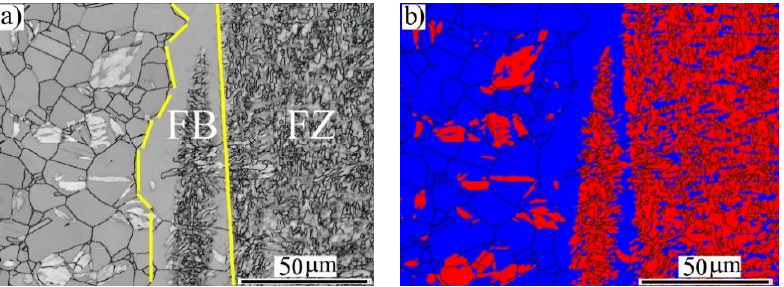
Figure 6. EBSD imaging maps of the fusion zone (FZ) near the fusion boundary (FB) of the BM-ASS at an EI of 160 J/mm: ( a ) image quality (IQ) map; ( b ) phase map of α (cid:48) - bct in red and γ - fcc austenite in blue.